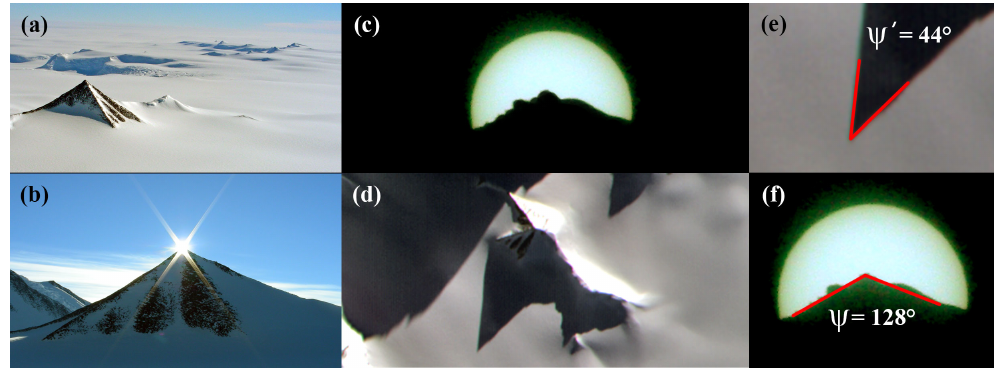
Figure 5. ( a ) Schatz Ridge Peak in the Sentinel Range, Antarctica (Latitude 78.5°S). This Peak was used as one of the validation points for this method. ( b ) Schatz Ridge Peak, as seen from the center of the shadow of its summit. ( c ) Close-up of the summit (projector) with a solar filter from the center of the projected shadow. Note that limb darkening is noticeable. ( d ) Schatz Ridge in a scene taken on 23 December 2004, with a Sun elevation of 12.4°. ( e ) Close-up of ( d ) with the value of the angle ψ (cid:48) . ( f ) Close-up to ( c ) with the value for the angle ψ